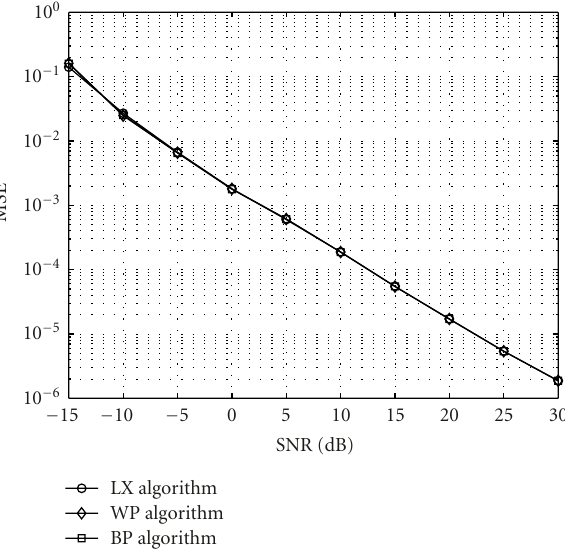
Figure 6: The MSE of the estimated channel versus SNR for (cid:25) Γ v = diag { 20,5,3 } and di ff erent matrices (cid:25) U v . The BP algorithm.